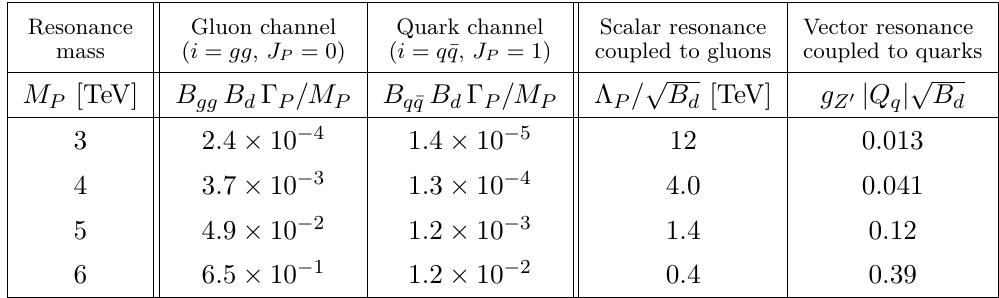
Table 2 . The combinations B i B d Γ P /M P required to reproduce the ATLAS dE/dx signal, in the case of gluon and quark channels. Also shown are the predictions for the combinations Λ P / (for the model with scalar resonance coupled to gluons) and g Z 0 | Q q resonance coupled to